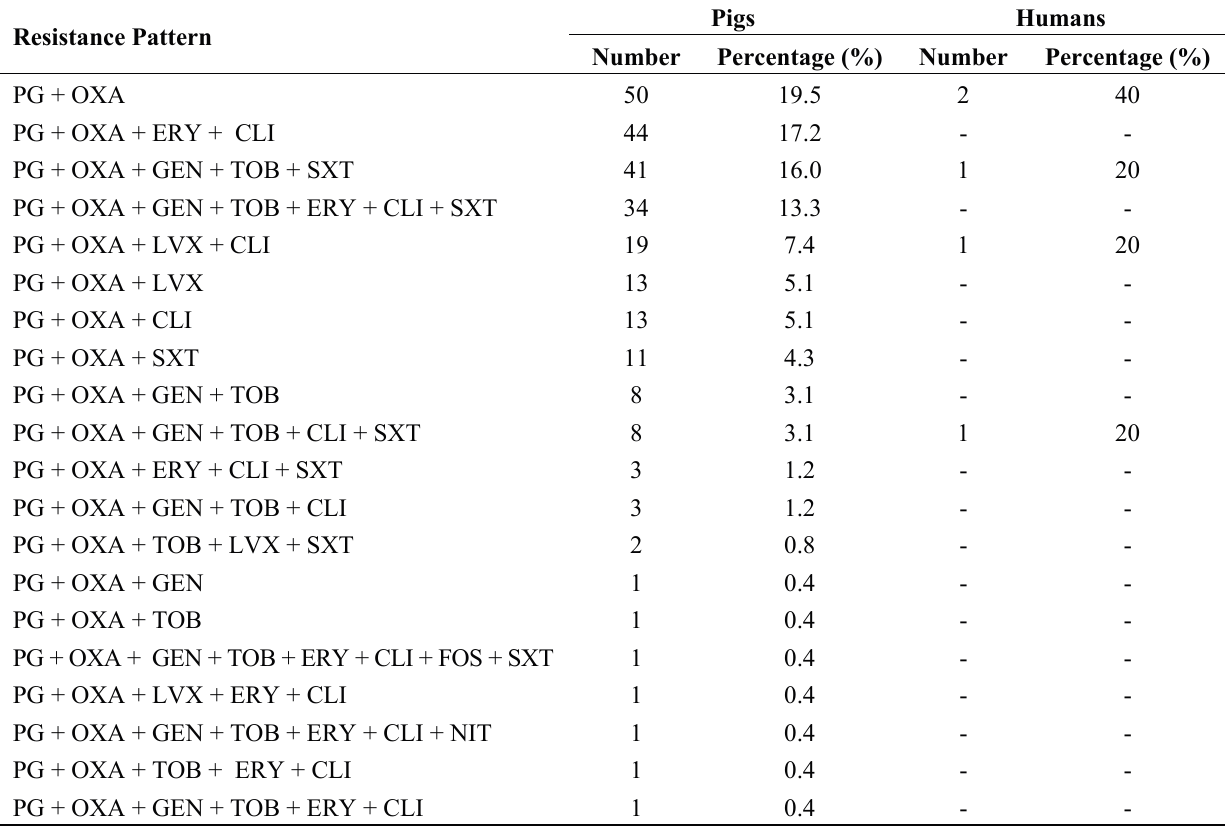
Table 2. Resistance patterns of MRSA